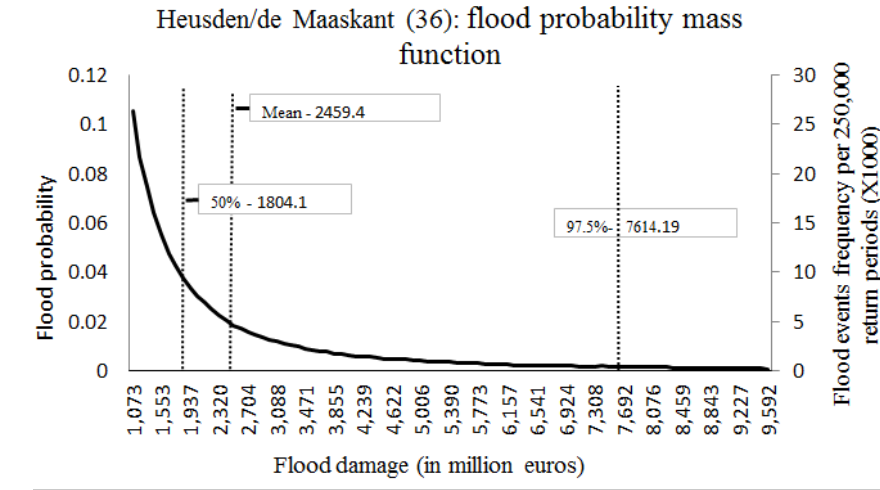
Figure 3: Simulated flood-damage density for the dyke-ring Noordoostpolder (7) Figure 4: Simulated flood-damage density for the dyke-ring Zuid-Holland (14)